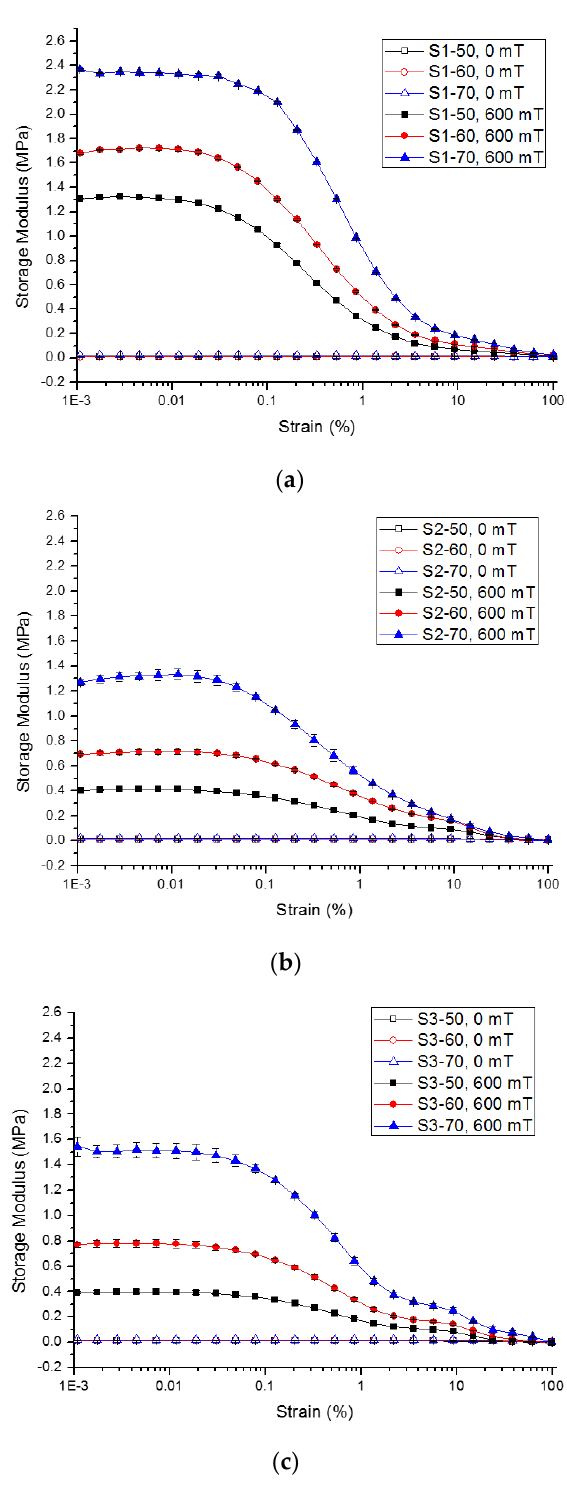
Figure 4. The dependencies of G’ ( a ) Sample 1 ( b ) Sample 2, and ( c ) Sample 3 as a function of strain amplitude. (* at constant frequency, f = 1 Hz ).